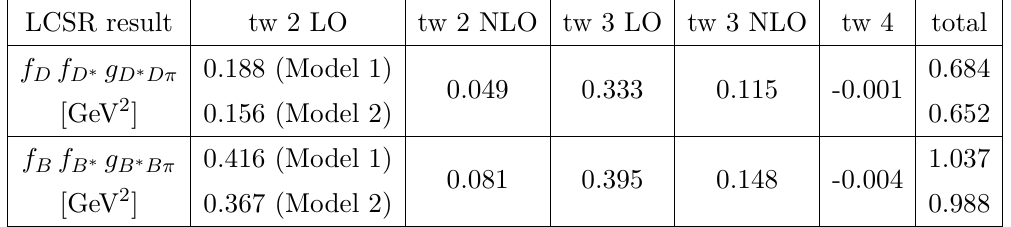
Table 4 . Numerical results at the central input.